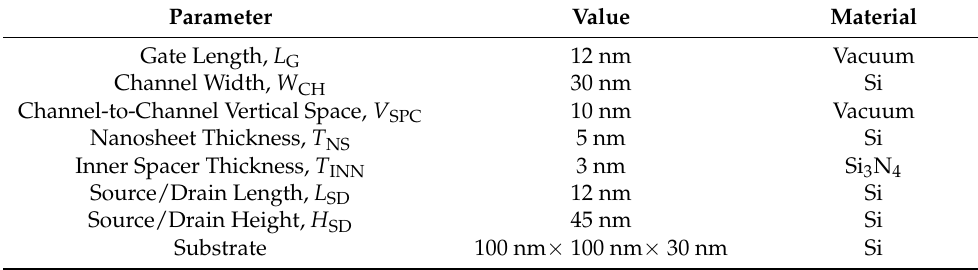
Figure 2. ( a ) Schematic geometry of Figure 1e for mechanical simulations. ( b ) Cross-sectional view of structure along x-direction. ( c ) Cross-sectional view of structure along the y-direction. Table 1. Parameters for Mechanical Simulation.